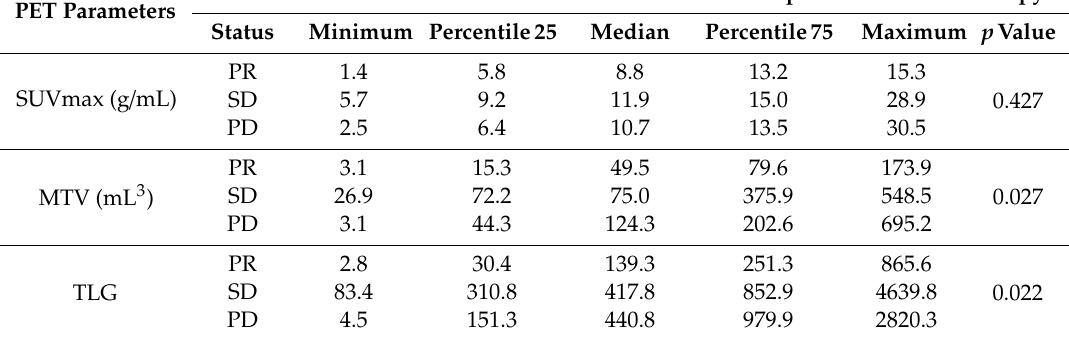
Table 4. Association of MTV and TLG with response to immunotherapy, as assessed by response evaluation criteria in solid tumors (RECIST) 1.1 criteria and clinical